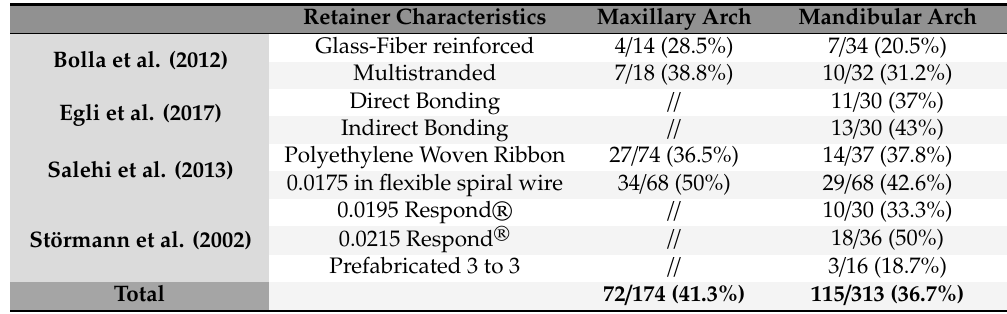
Table 4. Fixed retainer failure